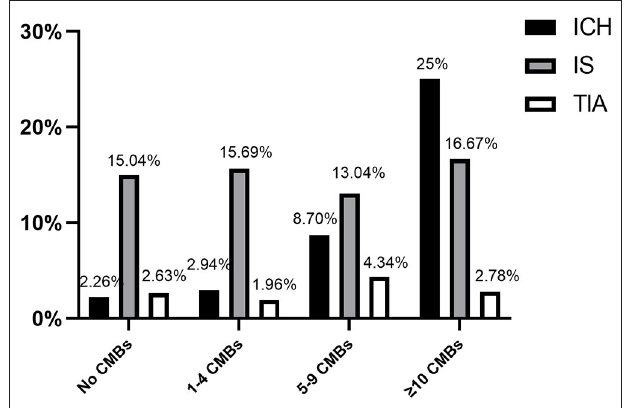
FIGURE 1 | Main study endpoints, separated based on number of CMB events (ICH, intracerebral hemorrhage; IS, ischemic stroke recurrence; TIA, transient ischemic